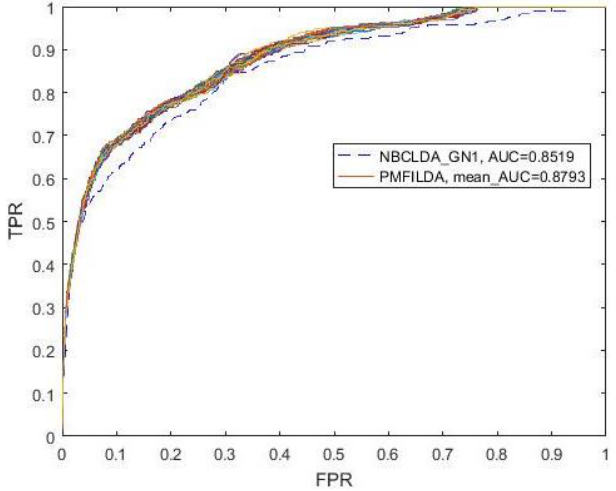
Figure 4. ROC curves and AUC value for NBCLDA GN 1 and PMFILDA.